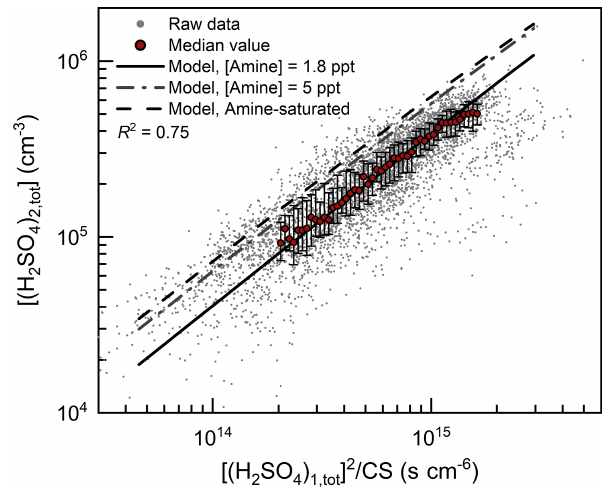
Figure 2. The measured and simulated H 2 SO 4 dimer, trimer, and tetramer concentrations. The concentrations of clusters containing the same H 2 SO 4 molecule number are summed together. The small dots are the raw data on both NPF and non-NPF days with a tem- poral resolution of 10min, and their median values are shown with big markers. The simulation condition was case specific for each raw data dot. The error bars indicate the lower and upper quartiles. The uncertainty of instrument detection efficiency contributes to the difference between the measured and simulated values, as explained in the main